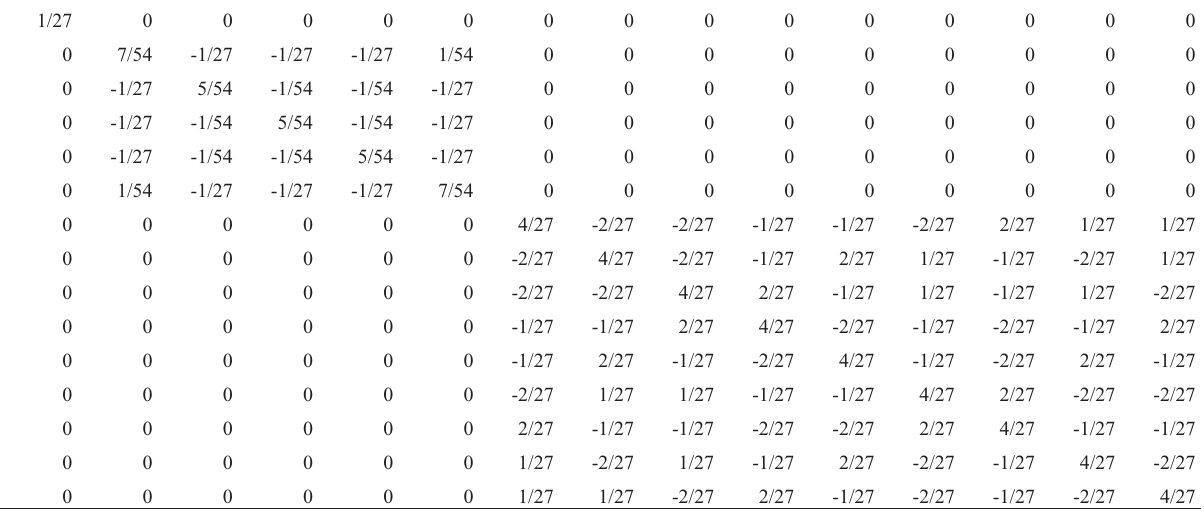
Table 11 - Estimates of the variances and covariances of the effects for an incomplete diallel model (Case 1, type 2 constraints) calculated using a matrix approach.